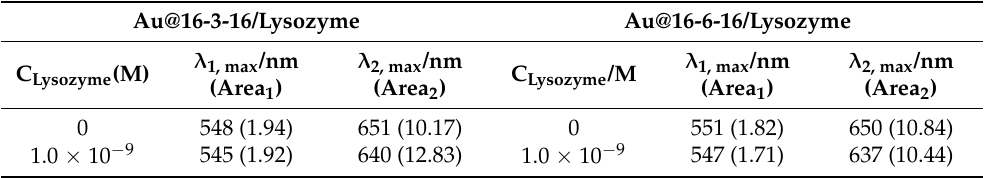
Table 6. Deconvolution parameters obtained from Au@16-s-16 spectra in the presence of Lysozyme and SDS following the addition method A. Gold nanoparticle and SDS concentrations were fixed in all experiments (C Au@16-3-16 = 0.174 nM, C Au@16-6-16 = 0.138 nM, and C SDS = 30 µ